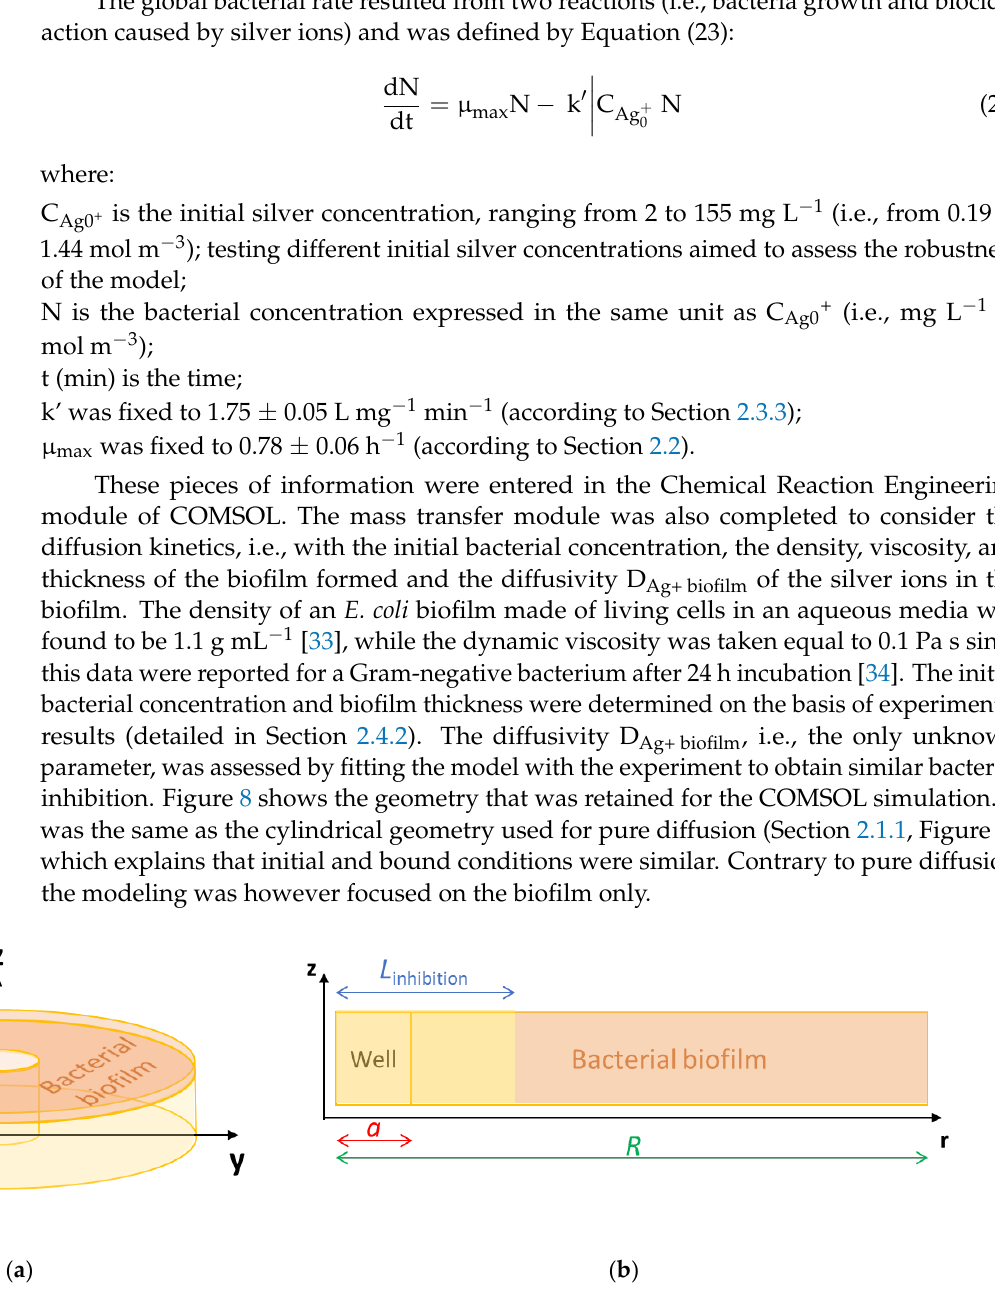
Figure 8. COMSOL geometry: ( a ) for the whole plate and ( b ) localized to the biofilm only.